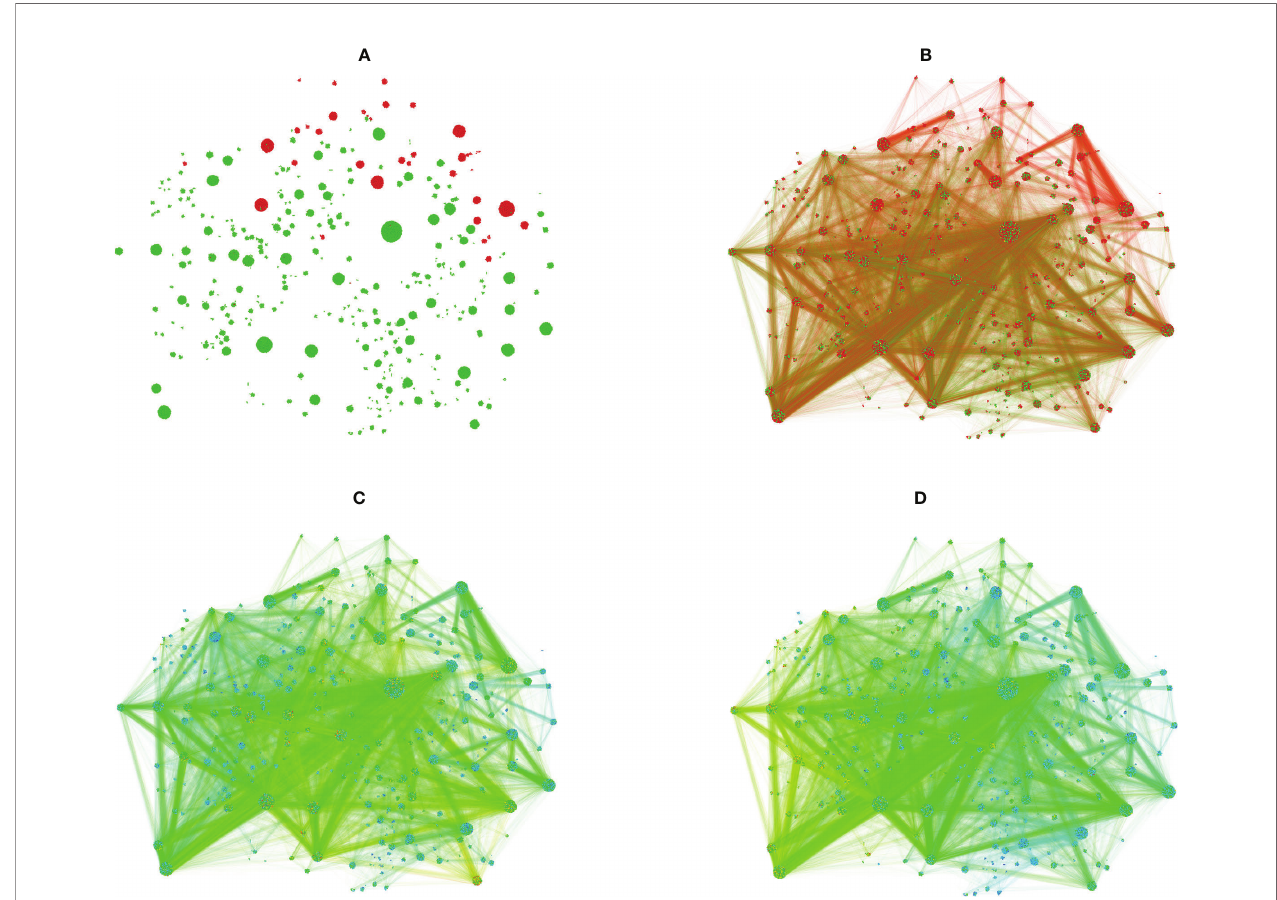
FIGURE 9 | Subgraph including the sequences in the signi fi cant clusters produced using the Gephi software. (A) – edges are hidden, coloring by type of NGcl or WGcl cluster, red – A, green - C A vertex gets the color of the cluster it belongs to, e.g. - a C library sequence in a cluster with predominance of A sequences will be red and not green. The spots are actually very dense clusters of vertices (sequences). The clustering shown is a result of application of the OpenOrd layout algorithm (51) and is unsupervised with respect to the clustering of the data in NGcl and WGcl sets of clusters. Therefore, the clusters seen in the plot are not the original NGcl or WGcl clusters, they are split in a different way so, for instance, there are more A clusters but the overall grouping is preserved so the clusters shown here remain of a homogenous color. (B) – the same layout with edges. Unlike the previous panel, here the coloring of each vertex and the adjacent edges is according to library the respective sequence belongs to, red – A , green – (C) Above and below are seen regions with high predominance of resp. A and C vertices. The majority of the C clusters have also considerable numbers of A vertices so, for instance, clusters which appear green in (A) here have both red and green spots but the cluster they belong to has a signi fi cant predominance of C sequences hence the overall green color in (A) . (C) – the same layout as in (B) color coded for number of G (public) sequences in the neighborhood of each vertex. The color ranges from blue (lowest) through yellow to red (highest) number. (D) – the same layout and color scheme as in (C) but the color code refers to the number of I (idiotope) sequences in the neighborhood of each vertex. Interestingly, the most idiotypically relevant clusters are away from the regions with higher diagnostic speci fi